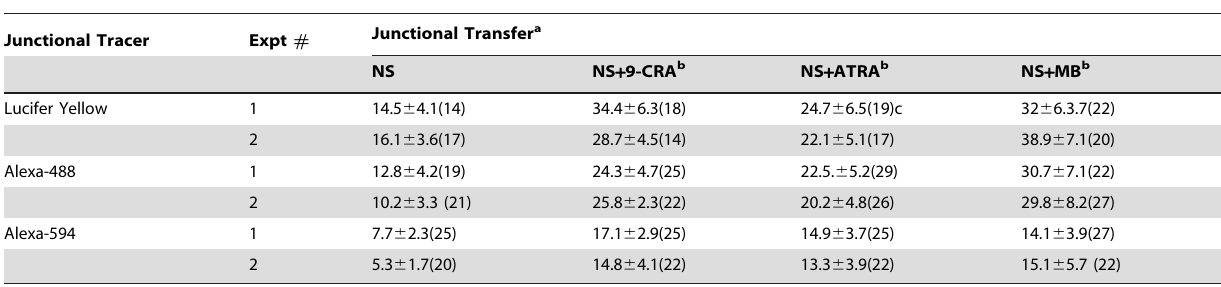
Table 1. Effect of 9-CRA, ATRA, and androgen on junctional transfer in LNCaP-32 cells.